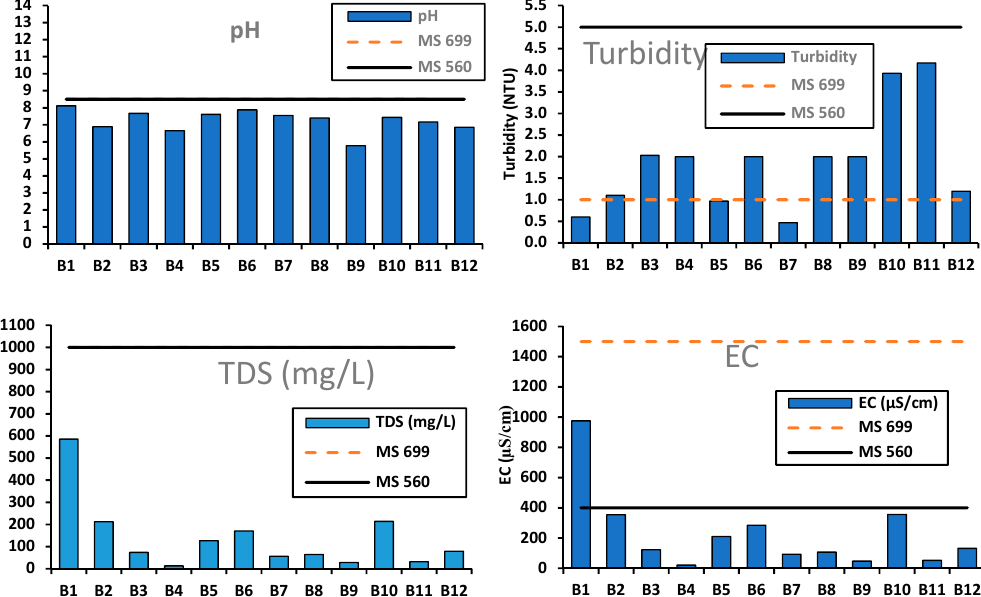
Figure 2. Variations in water quality (pH, turbidity, EC and TDS) of the bottled water compared to MS 699 (treated bottled water) and MS 560 (natural mineral water) standards. Data for each brand is the Int. J. Environ. Res. Public Health 2019 , 16 , x mean values of the total samples ( n = 30).